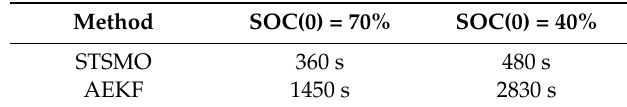
Figure 17. SOC convergence process for the DST discharge profile at different initial SOCs. Table 4. SOC convergence time at different initial SOCs.